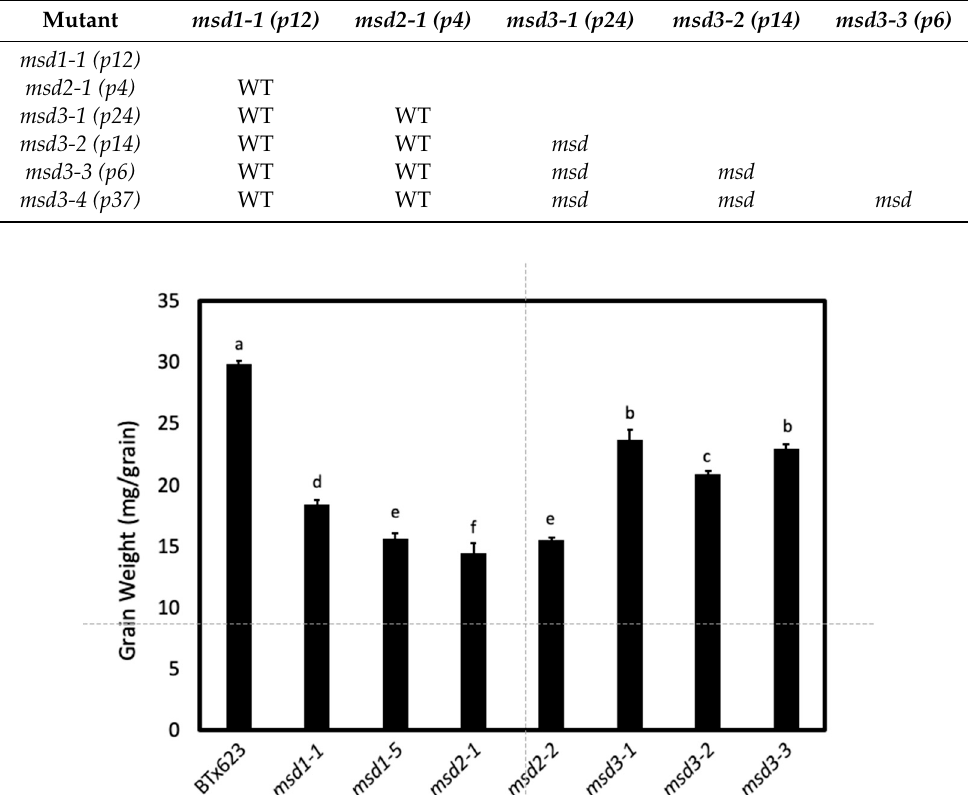
Figure 1. Comparison of grain weight (mg / grain) of msd3 mutants vs. BTx623 and the msd1 and msd2 mutants. Grain weight was determined from plants planted on the Farm of Texas Tech University on Quaker Avenue in 2017. Four samples of 100 grains were weighed from each line. One-way ANOVA analysis revealed that grain weight varied significantly with an F-value of 276 and p-value of 1.8 − 15 . Grain weights labeled with different letters are significantly different.